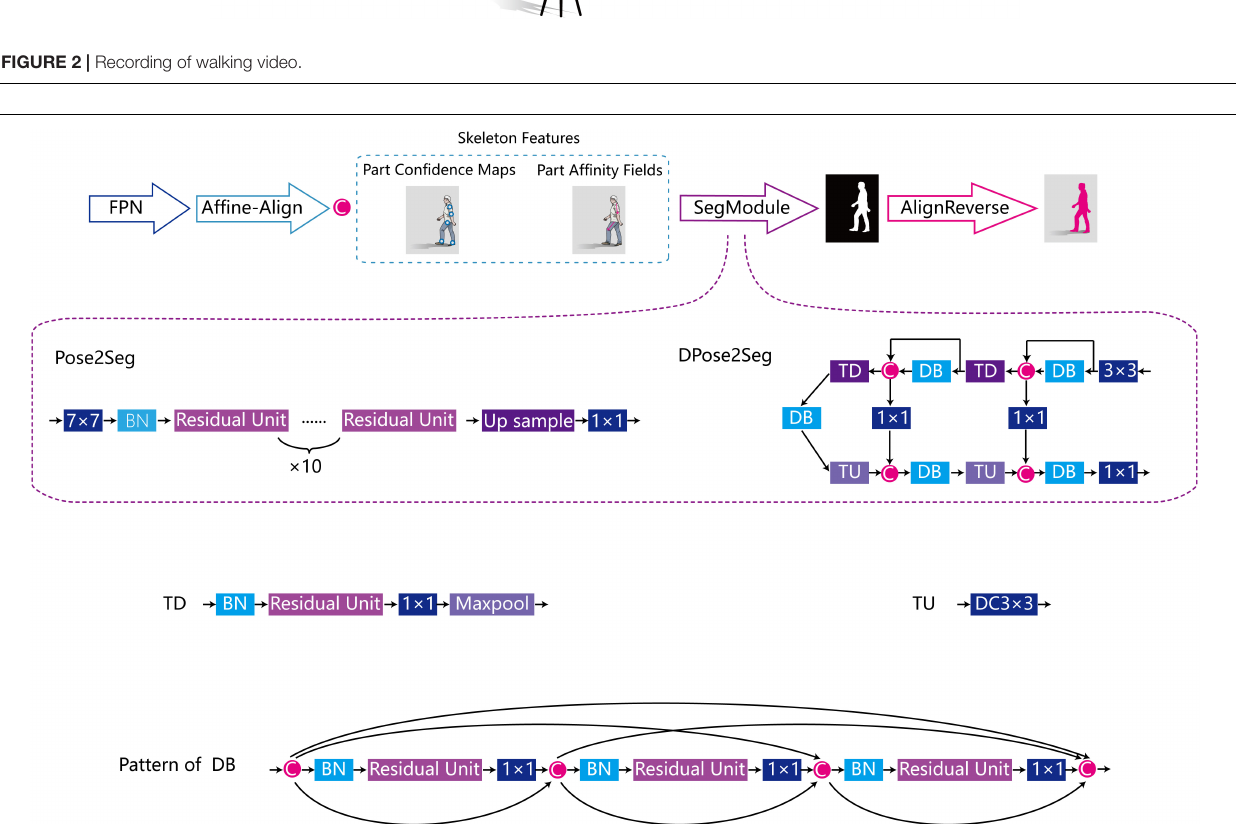
FIGURE 3 | Frame structure of Pose2Seg and DPose2Seg. FPN, feature pyramid network; 7 × 7: 7 × 7 convolution kernel; 1 × 1: 1 × 1 convolution kernel; DC3 × 3: 3 × 3 deconvolution kernel; SegModule, segmentation module; BN, batch normalisation; DB, dense block; US, up sample; TD, transition down; TU, transition up; C,